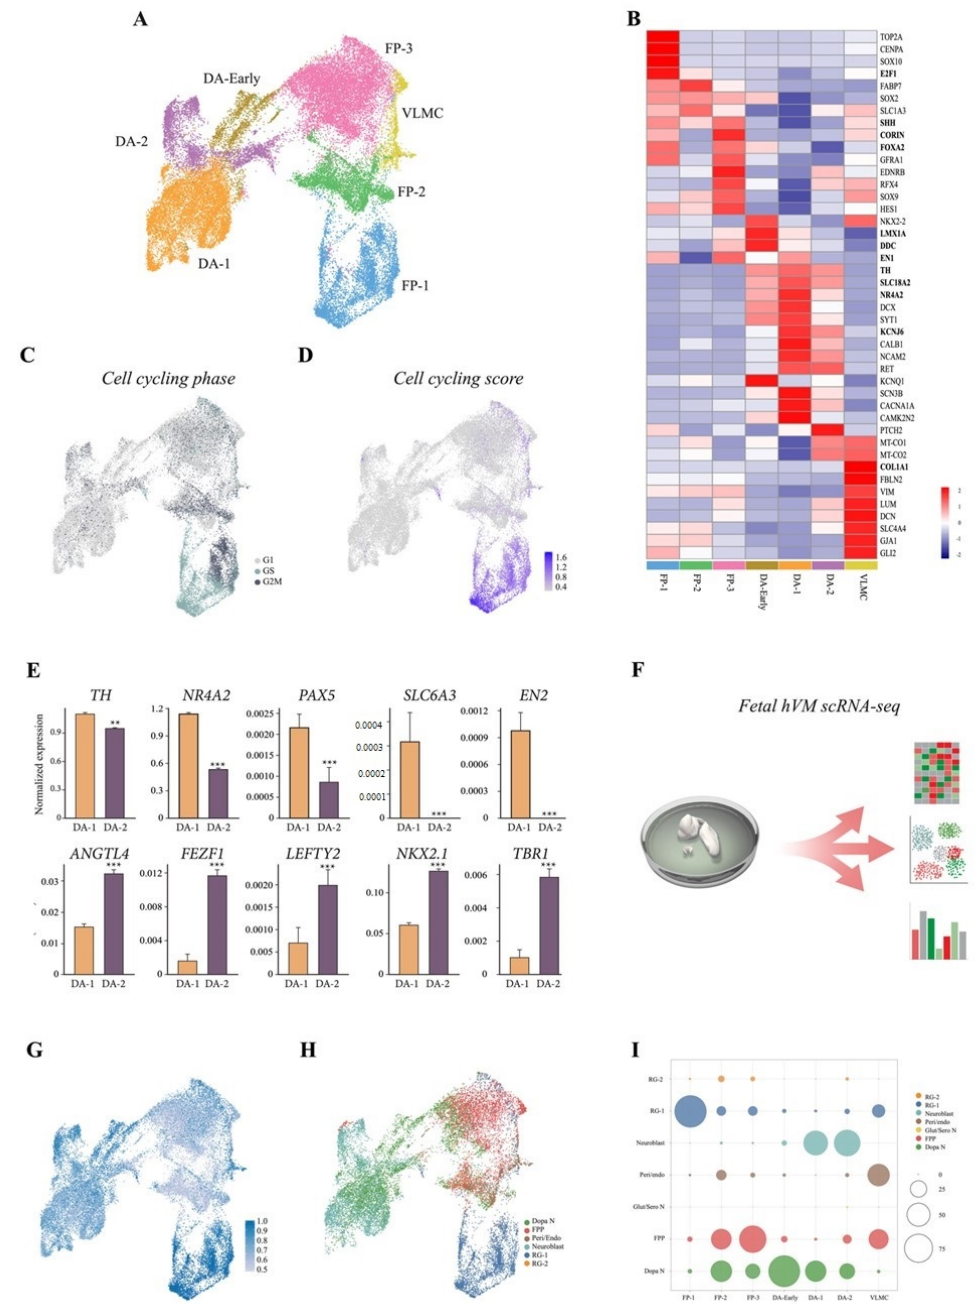
Figure 2. Single-cell RNA sequencing (ScRNAseq) captures distinct cell-type identities during human pluripotent stem cell DA neuron differentiation. ( A ) Uniform manifold approximation and projection (UMAP) plot embeddings of 19,841 cells from VM cultures at day 16, 30, and 60. Cell-type assignments are indicated. ( B ) Heat map showing expression levels of selected genes for each cluster. Values are given as standard deviations relative to average expression across all clusters. ( C ) UMAP embeddings showing the predicted cell cycle phase. ( D ) Cell-cycling score (S.Score + G2M.Score) calculated using Seurat CellCycleScoring function. ( E ) Bar plot of DA-1 and DA-2 clusters showing expression of meso/diencephalic markers. Data represent mean ± SEM, ∗∗ p < 0.01, ∗∗∗ p < 0.001. ( F ) Schematic overview of the experimental design. ( G ) UMAP embeddings of prediction score for human fetal VM cells from three separate fetuses (6, 8, and 11 weeks post-conception) vs. hPSC VM-derived culture cell types. ( H ) Predicted cell types using fetal derived cell types as reference. ( I ) Relative overlapping quantification (% cells overlapping) of human fetal midbrain vs. hPSC VM culture